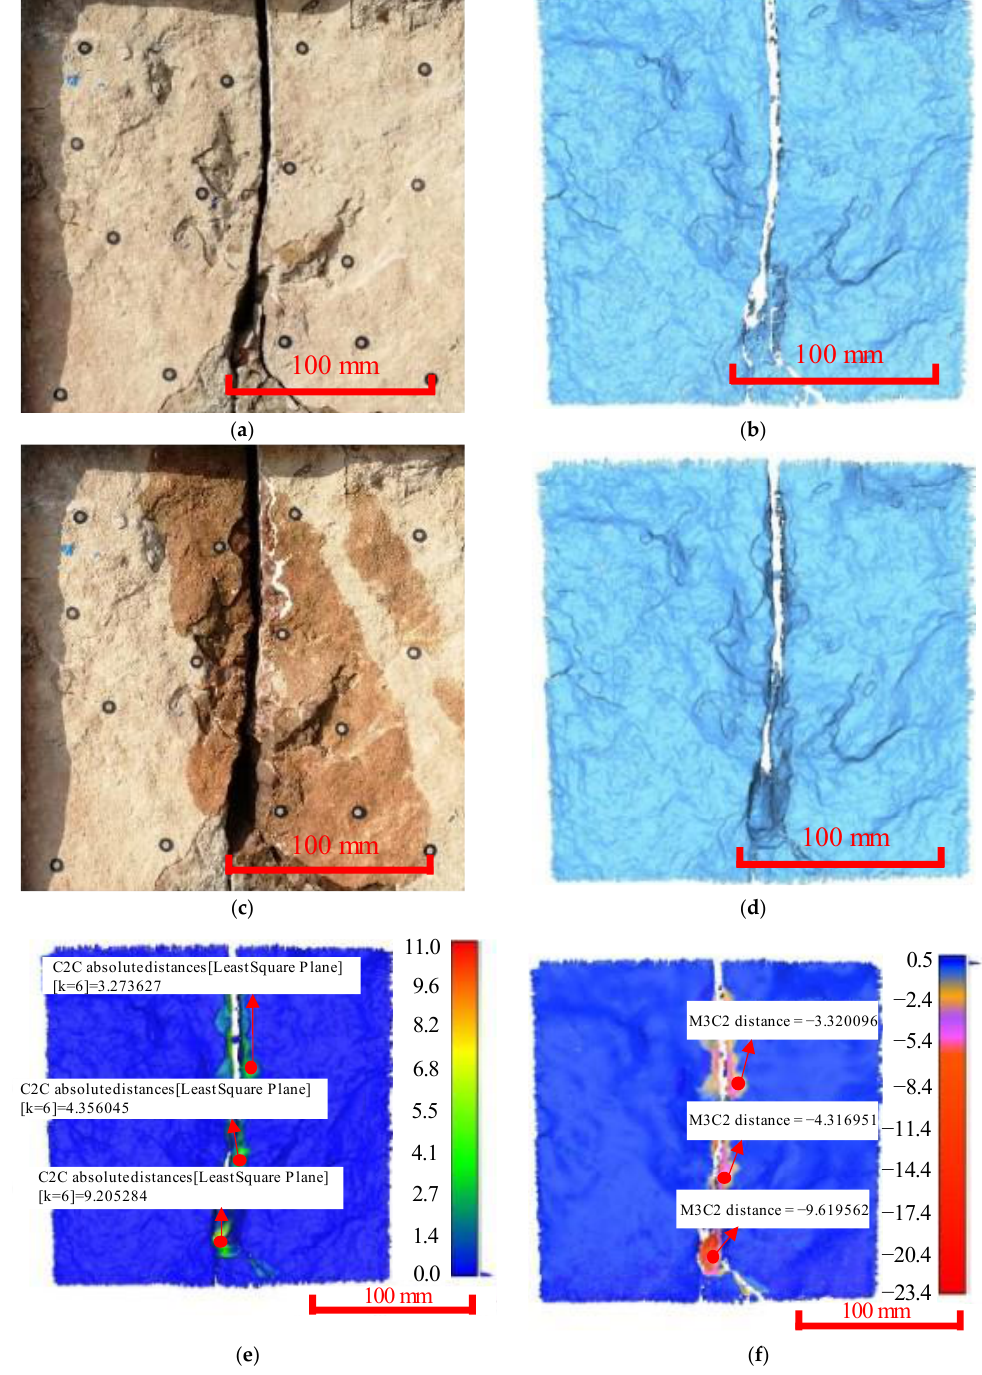
Figure 5. In situ and 3D cloud diagram of vertical joints. ( a ) Site picture of the measuring area (Period I). ( b ) Image of the 3D laser scanning (Period I). ( c ) Site picture of the measuring area (Period II). ( d ) Image of the 3D laser scanning (Period II). ( e ) Deformation distribution obtained using the C2C method. ( f ) Deformation distribution obtained using the M3C2 method.